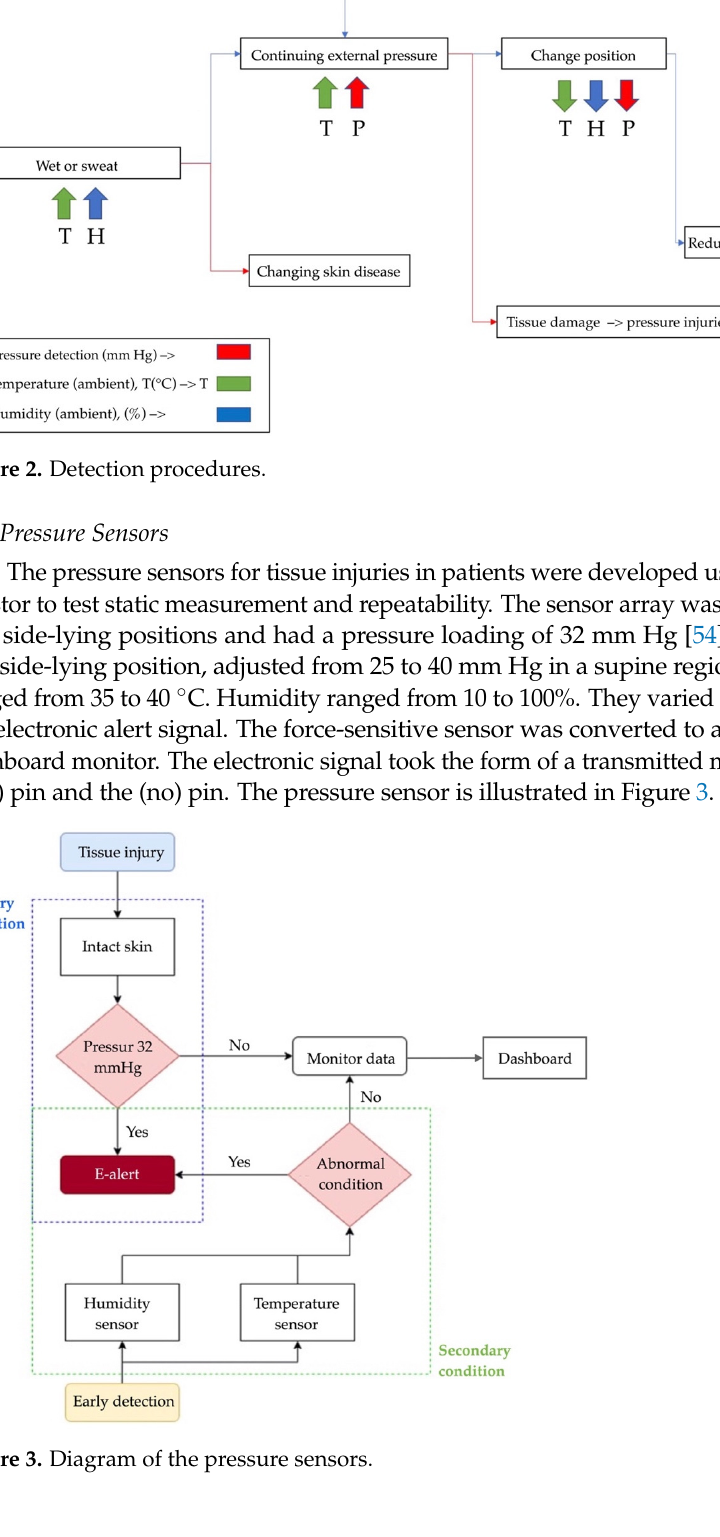
Figure 3. Diagram of the pressure sensors.